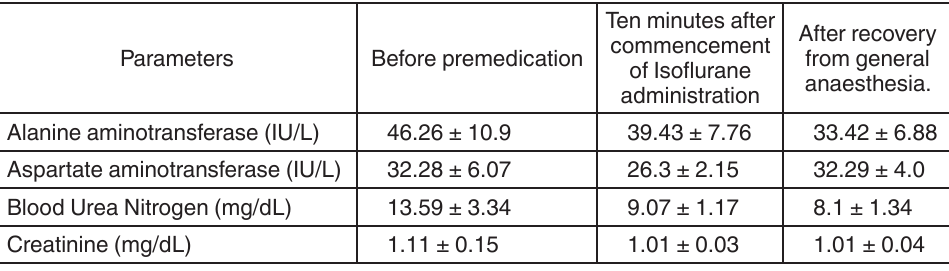
table 2. Observations on serum biochemistry profile (Mean ± SE) n=6 Parameters